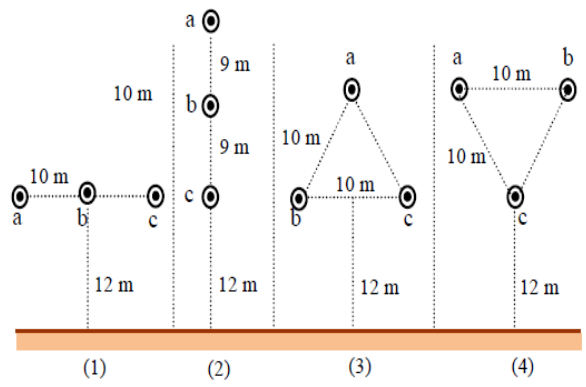
Figure 4: Different configurations of single circuit lines - (1) Horizontal, (2) Vertical (3) Triangular, (4) Inverted triangular.